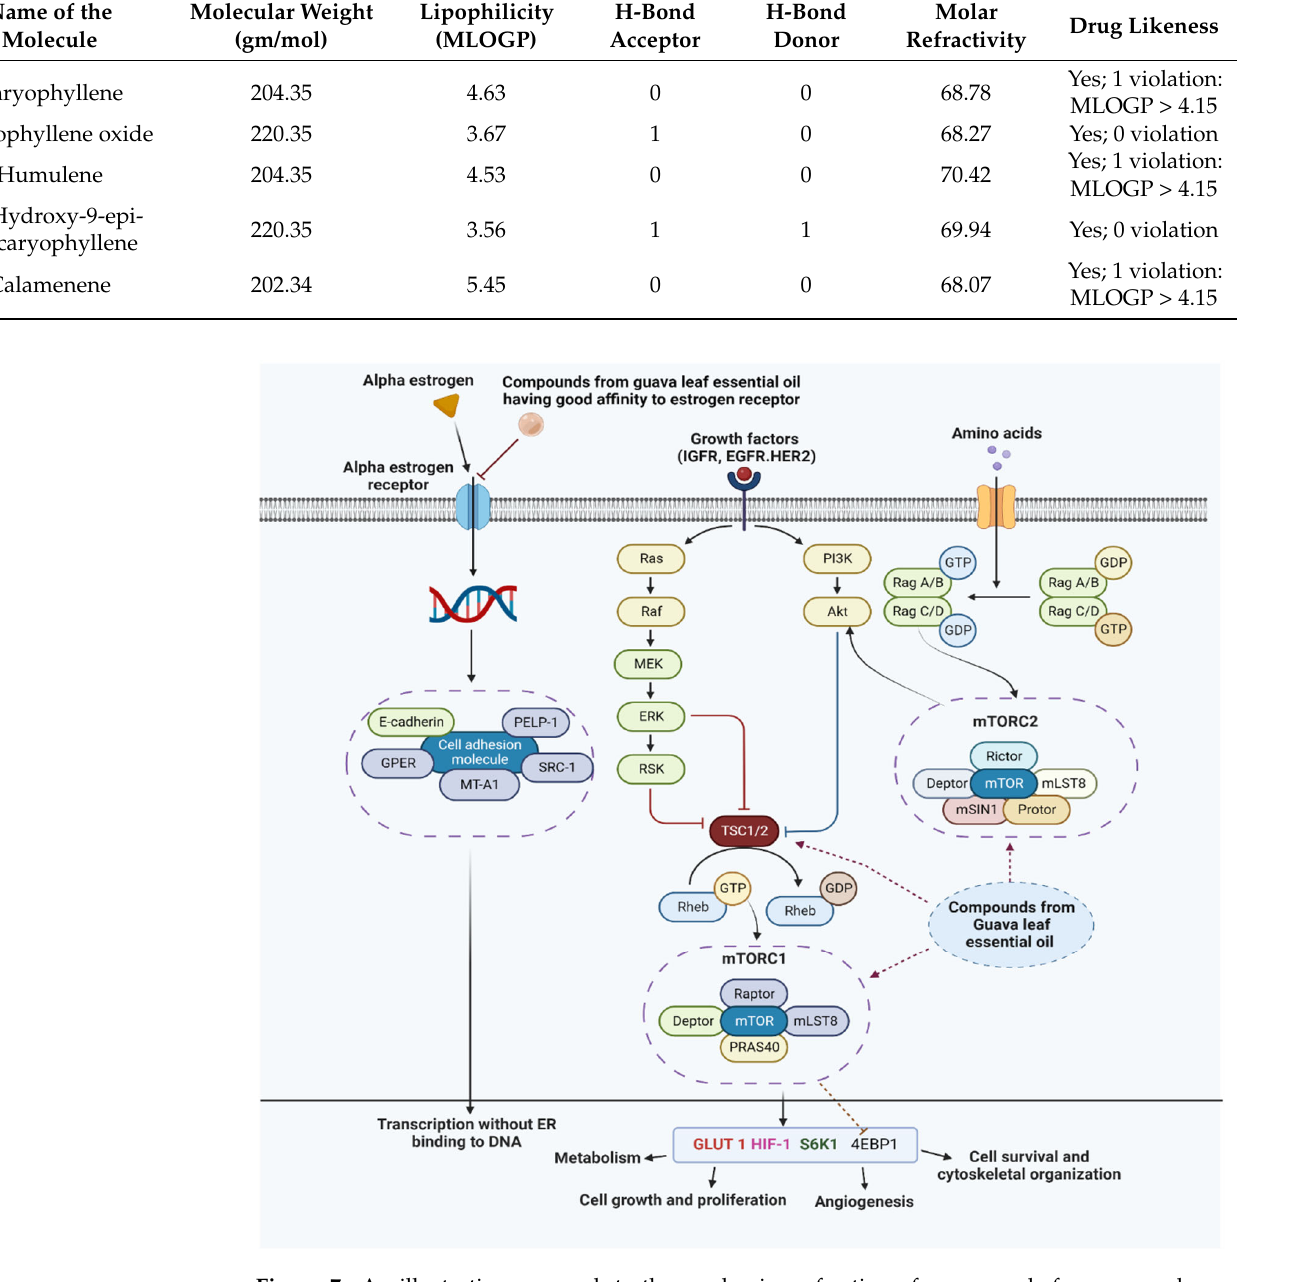
Figure 7. An illustrative approach to the mechanism of action of compounds from guava leaves essential oil against estrogen receptor. RTKs: Receptor tyrosine kinase; EGFR: Epidermal growth factor receptor; HER2: Human epidermal growth factor receptor 2; IGFR: Insulin ‐ like growth factor receptor; SRC: Steroid receptor co ‐ activator; pi3K: Phosphoinositide 3 ‐ kinase; ERK: Extracellular signal regulated kinase; PELP: Proline, Glutamate and Leucine Rich Protein; MT A1: Metastasis Associated Protein ‐ 1; GPER: G ‐ protein coupled estrogen receptor; TSC: Tuberous sclerosis; 4EBP1: Eukaryotic initiation factor 4E binding protein 1; PTEN: Phosphatase and tensin homolog; mTORC1/2: Mammalian target of rapamycin complex 1/2; HIF ‐ 1: Hypoxia inducible factor 1; Akt: protein kinase B; Glut1: Glucose transporter 1; GTPase: Guanosine triphosphatase; IRS: Insulin receptor substrate; PI3K: Phosphatidylinositol 3 kinase; S6K1: S6 kinase 1. (The Figure was generated using Bio ‐ render). 4. Conclusions In this article, we elucidated the composition of the essential oil of guava leaves in order to explore its antioxidant properties and anticancer potency. The GC–MS analysis of volatile oils revealed the presence of various anticancer compounds implying a promising DPPH ‐ Scavenging potency. The in vitro anticancer test accomplished using an MTT assay showed a promising result that indicated guava essential oil may work against hepatic and breast cancer cells at different concentrations. Similarly, the in silico study on anticancer activity revealed the high affinity of our reference ligand (hydroxytamoxifen) towards the receptor ( α‐ ER). Since, α‐ ER is primarily responsible for the progression of breast cancer and since hydroxytamoxifen, a metabolite of hormonal drug tamoxifen, showcased an excellent binding affinity with the receptor, our ligand may be beneficial as it inhibits the estrogen from binding with estrogen receptors, thereby inhibiting cancer